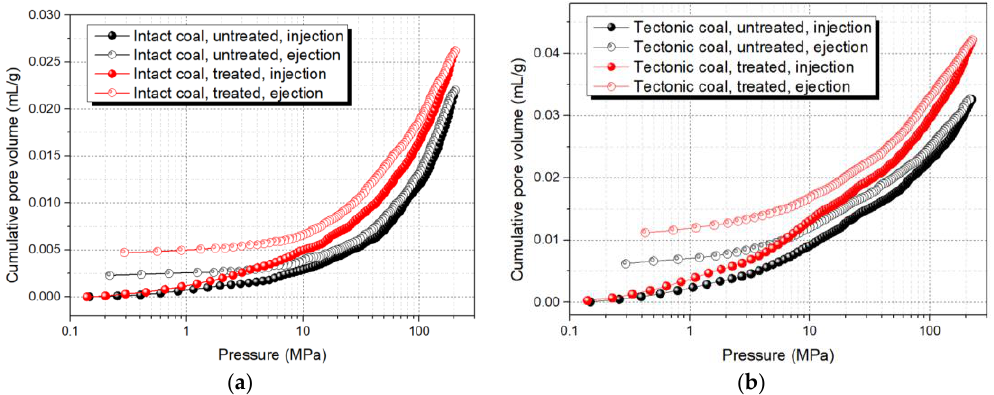
Figure 7. Mercury intrusion porosimetry injection and ejection curves for untreated and treated coal samples: ( a ) intact coal; ( b ) tectonic coal.